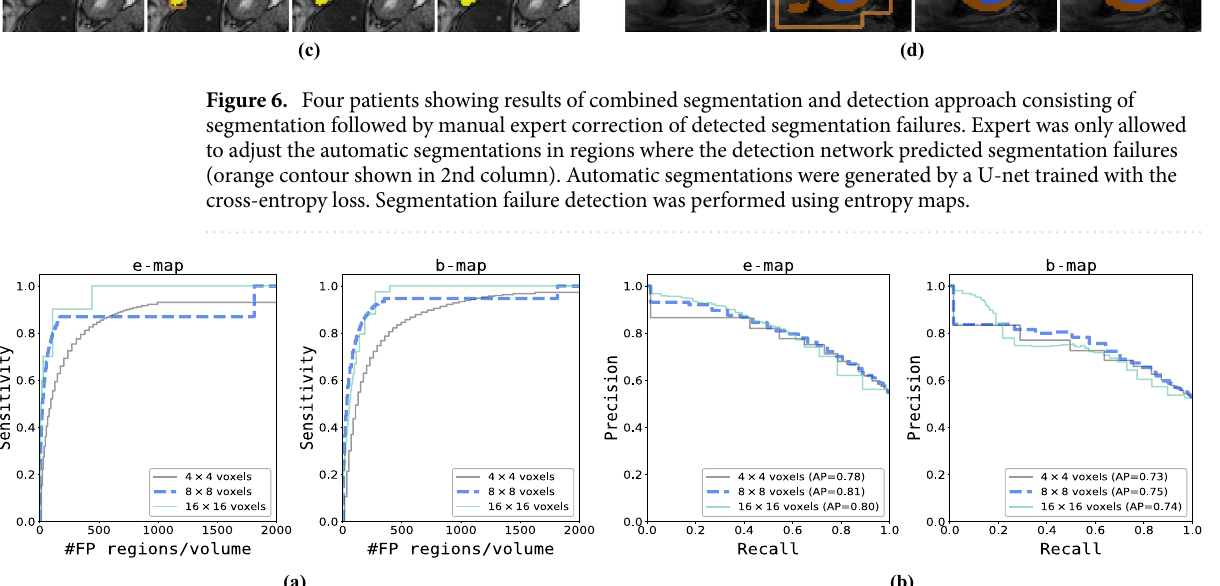
Figure 7. Detection performance for three different patch-sizes specified in voxels. (a) Sensitivity for detection of segmentation failures on voxel level (y-axis) versus number of false positive image regions (x-axis). (b) Precision-recall curve for detection of slices containing segmentation failures (where AP denotes average precision). Results are split between entropy and Bayesian uncertainty maps. In the experiments patch-size was set to 8 × 8